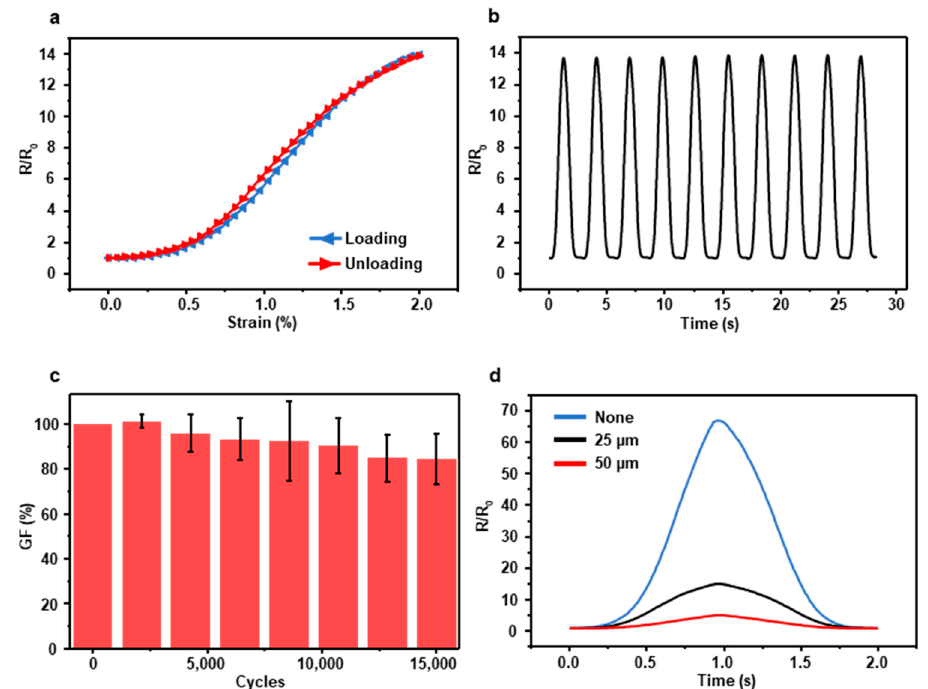
Figure 2. ( a ) Hysteresis curve of the sensor encapsulated with the 25 µm FEP film when the sensor receives loading and unloading force. ( b ) Normalized resistance at 0%–2% strain and 40 nm/s velocity. ( c ) The durability of the sensor encapsulated with the 25 µm FEP film. ( d ) Resistance variation depending on the thickness of the FEP film.